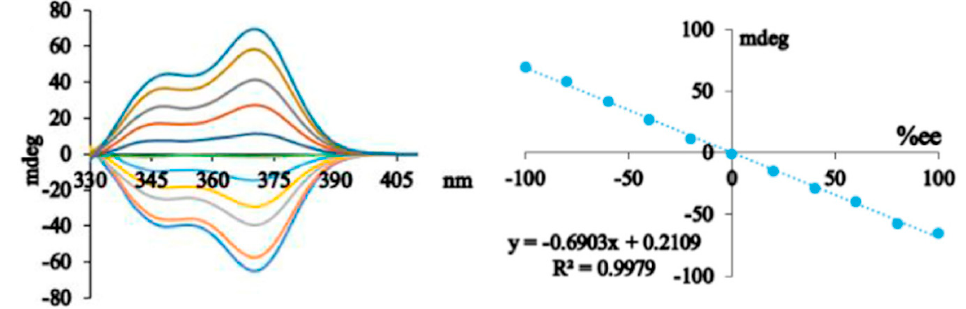
Figure 2. Circular dichroism (CD) spectra of the mixture obtained with oligo(phenylene ethynylene)s (Table 1, no. 4), Et 3 N, and samples of tartaric acid and linear relationship between the CD amplitude at 370 nm and the sample enantiomeric excess. Reprinted from [64] with permission from